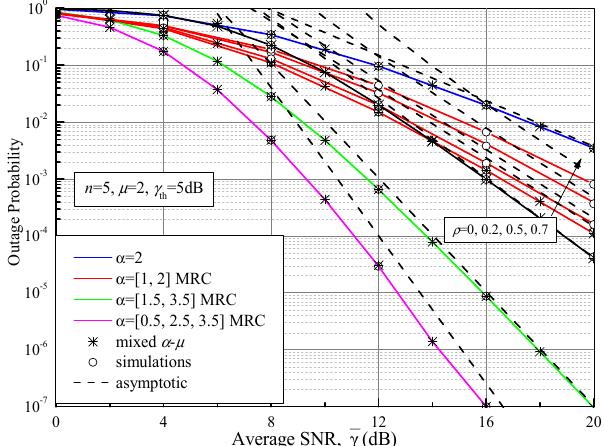
Figure 4. Outage probability of various communication systems as a function of the average SNR ( 𝛾̅ ) over i.n.i.d. and correlated α - µ /IGA fading channels with n = 5, µ = 2, and γ th = 5 dB.